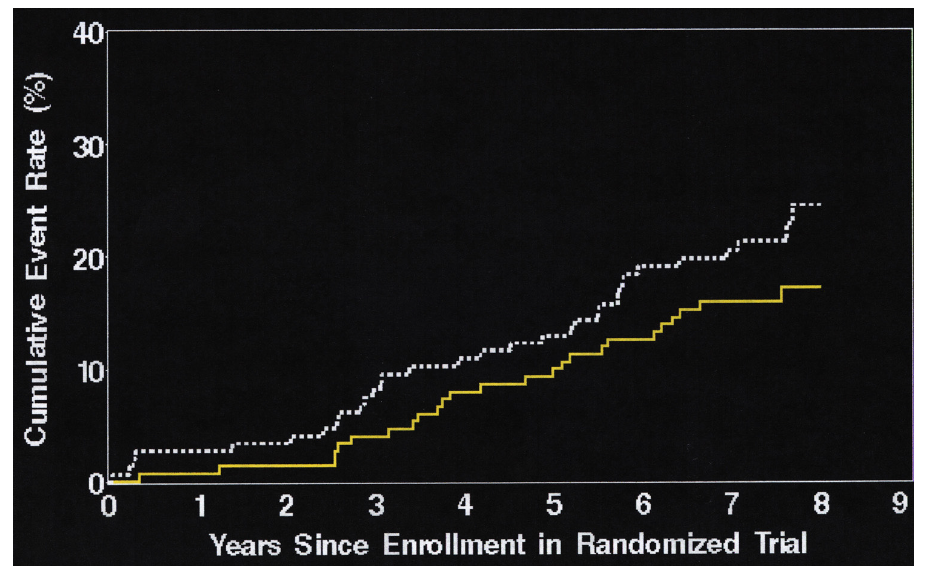
FIGURE 1. Cumulative mortality of patients originally randomized to receive hydroxyurea (yellow line) or a placebo (white line). Randomized treatment stopped after 2.5 years. The differences in mortality, when analyzed by original treatment assignment were not